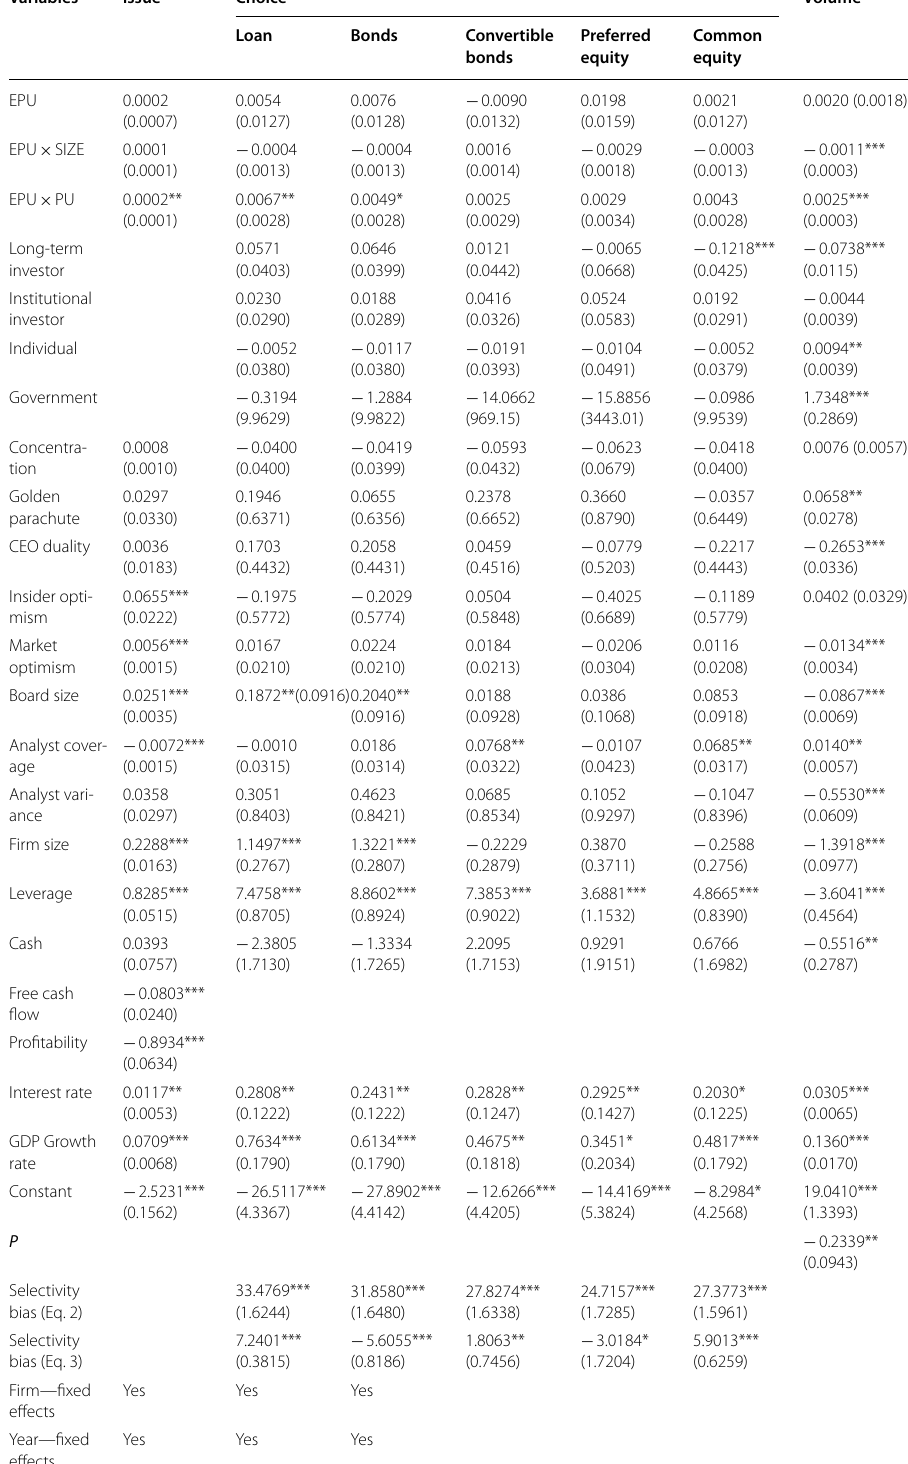
Table 7 Empirical estimation based on a multinomial logit model for the Choice equation